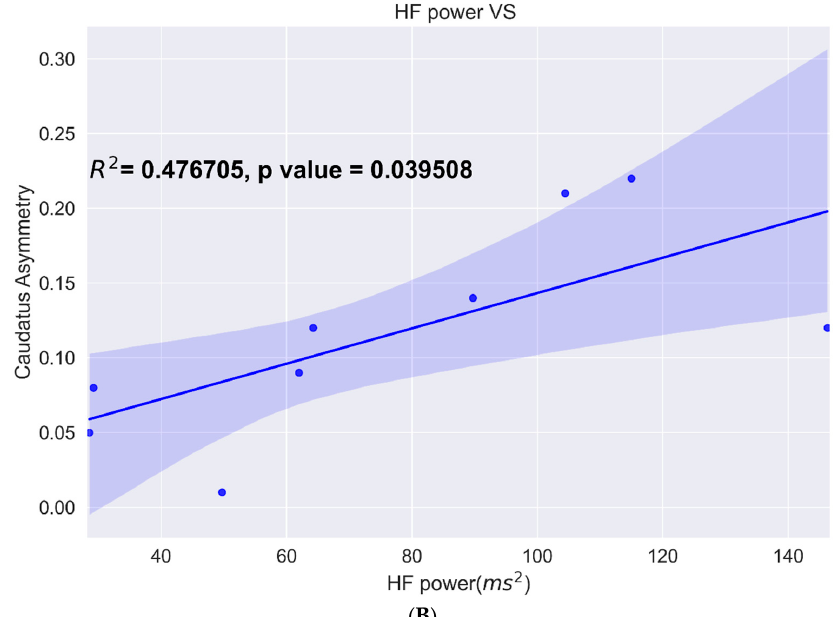
Figure 5. ( A ) Linear fit of posterior putamen binding ratio versus various HF power. ( B ) Linear fit of caudate asymmetry binding ratio versus HF power.